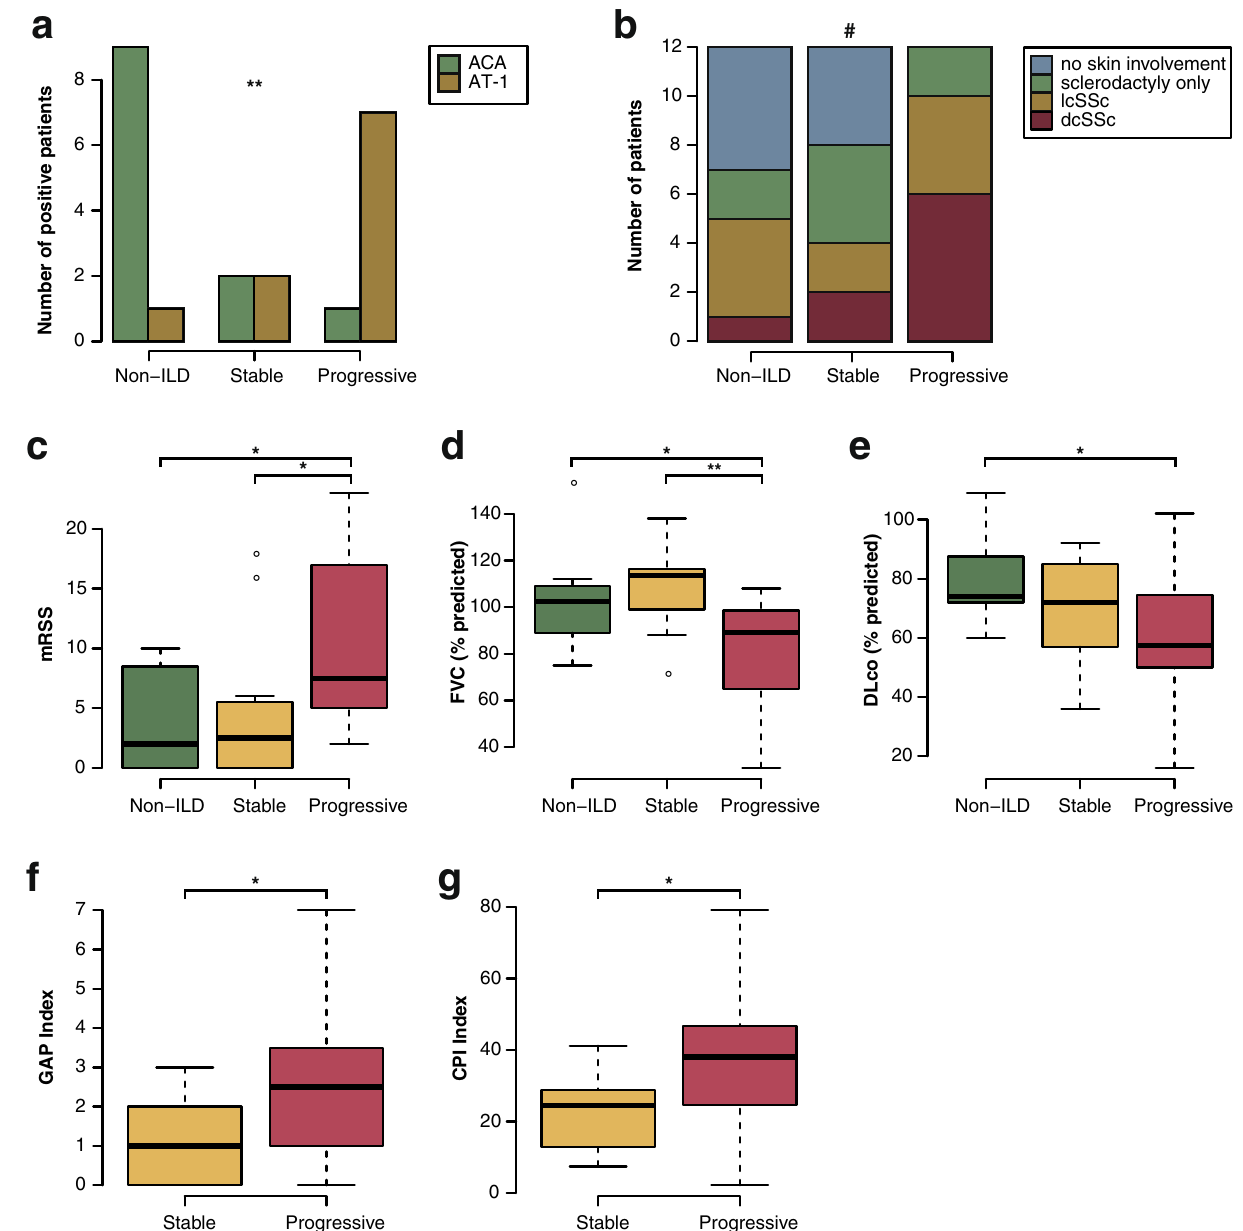
Figure 1. Clinical characteristics of SSc patients from the Zurich cohort at time point of sample collection. mRSS modified Rodnan skin score, dcSSc diffuse cutaneous SSc, lcSSc limited cutaneous SSc, ACA anti- Centromere antibodies, AT-1 anti-topoisomerase I antibodies, FVC forced vital capacity, DLco carbon monoxide diffusion capacity. *p ≤ 0.05, **p ≤ 0.01, ***p ≤ 0.001, # not significant. N = 12 per